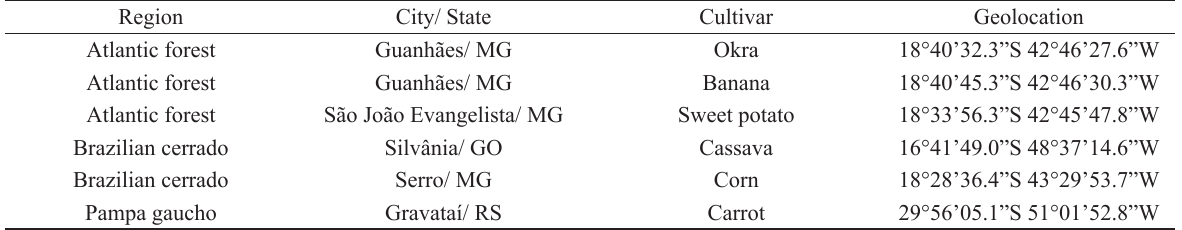
Plant cultivation and collection sites of soil samples in different regions of the states of Goiás (GO), Minas Gerais (MG) and Rio Grande do Sul